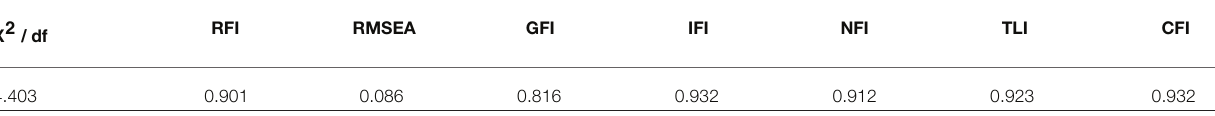
TABLE 4 | The fitting index of the research model.